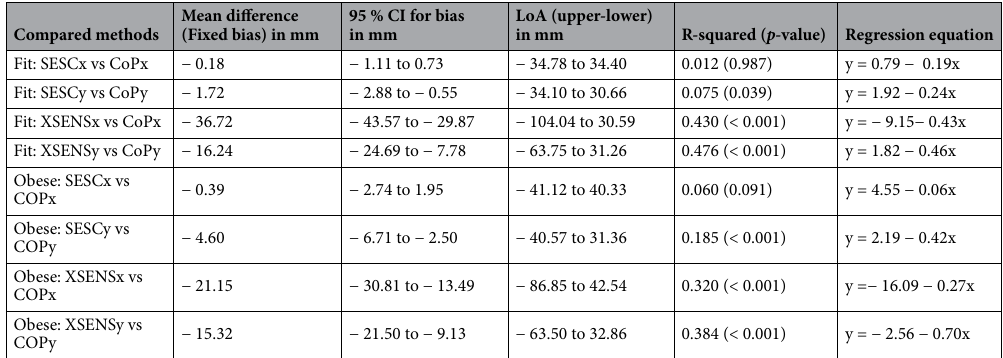
Table 4. Summary of the Bland-Altman variables of each comparison. The fixed bias is defined as the mean of the differences between the CoP and the estimated CoM values. The confidence interval (CI) is set at 95 % , LoA values are set as mean ± 1.96 ×